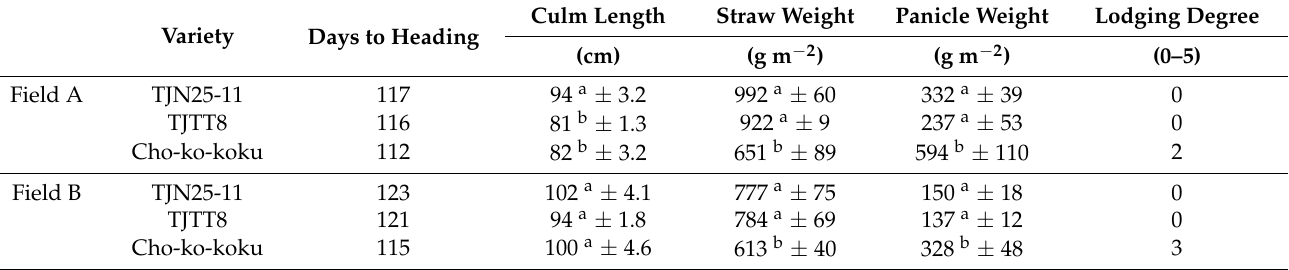
Table 3. Agronomic traits of rice varieties grown under early drainage water management in two farmers’